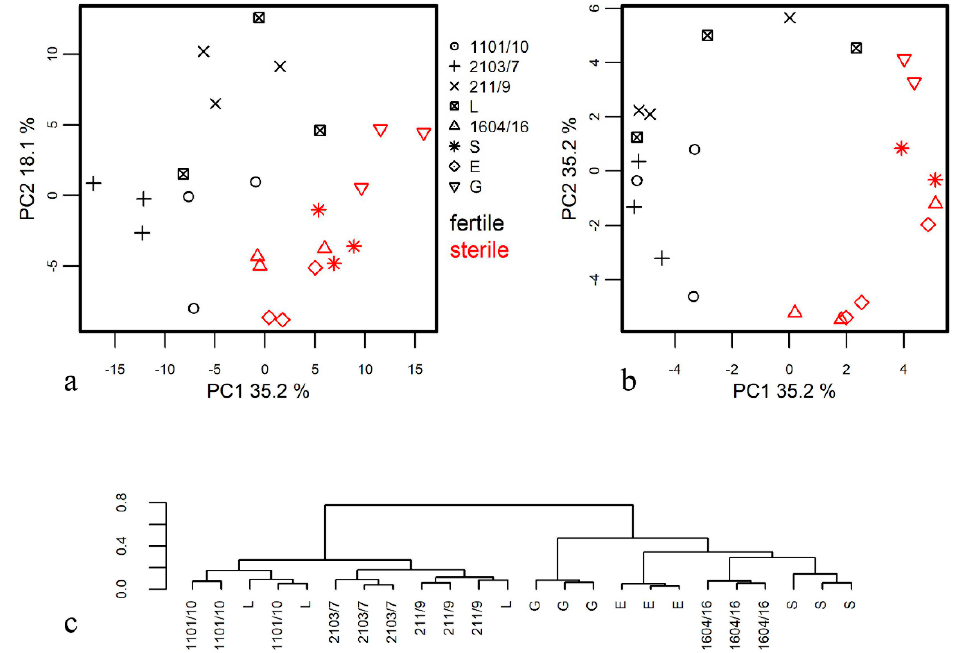
Figure 1. Clusterization of metabolite profiles of anthers at the mature pollen stage from male-fertile and male-sterile potato genotypes. ( a ) Principal Component Analysis (PCA) method of clusterization; ( b ) kernel PCA method of clusterization obtained with the hyperbolic tangent function; ( c) dendrogram of hierarchical clustering obtained using the ratios of metabolite contents. L–cv. Lomonosovskij, S–cv. Sudarynja, E–cv. Evraziya. G–cv. Gusar, 1101/10, 1604/16, 2103/7, 211/9-breeding lines.